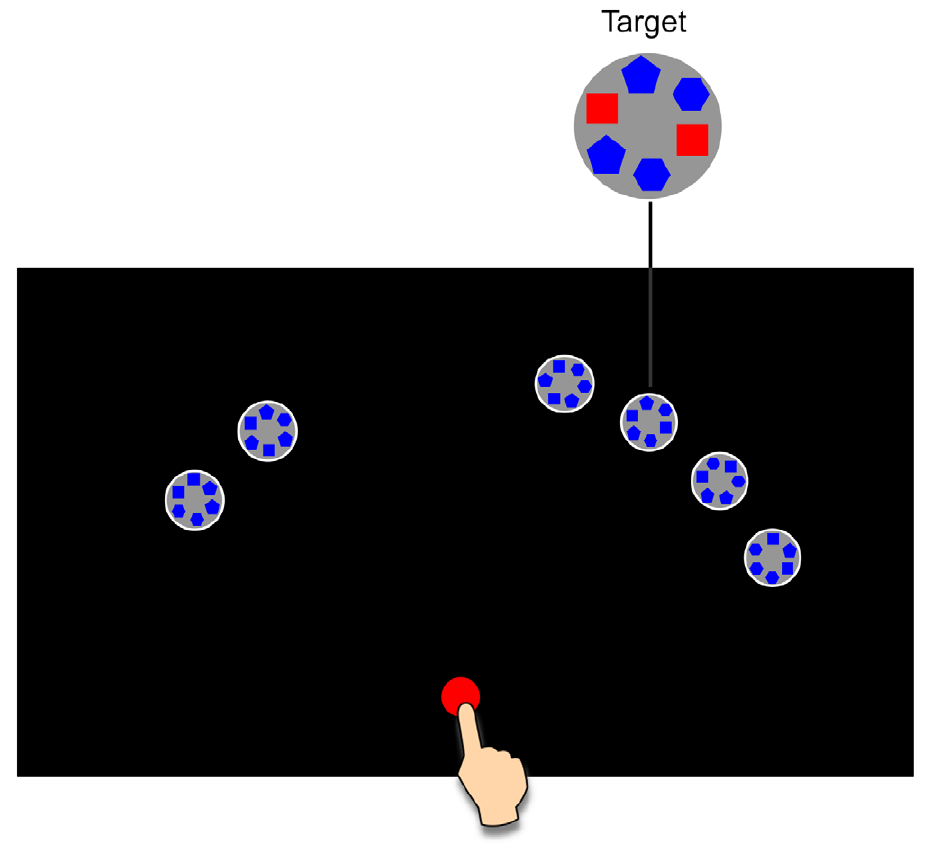
Figure 1. An example of the stimulus array. The red circle is the starting position for the eye and the hand. Each gray circle with blue shapes inside is an object. Two clusters of objects are located to the left and right of the midline, on a virtual arc centered at the starting position. One cluster contains four objects, the other two. On half the trials the two-cluster is on the left as shown, on the other half, on the right. Each object is equally likely to be the target. One and only one of them is the target to be touched. See the Stimuli section for a definition of the target and